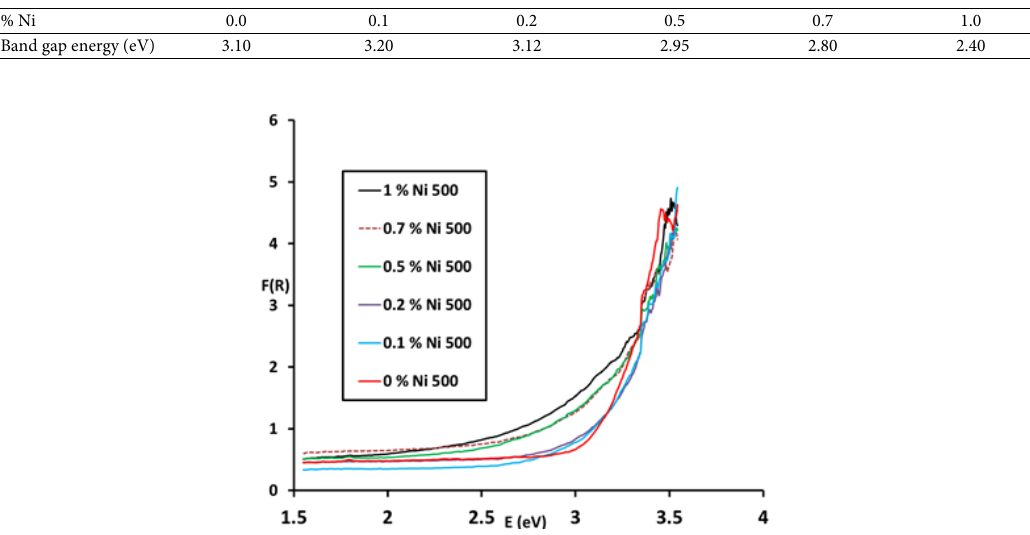
Fig. 13. Determination of bandgap energy of nickel doped TiO